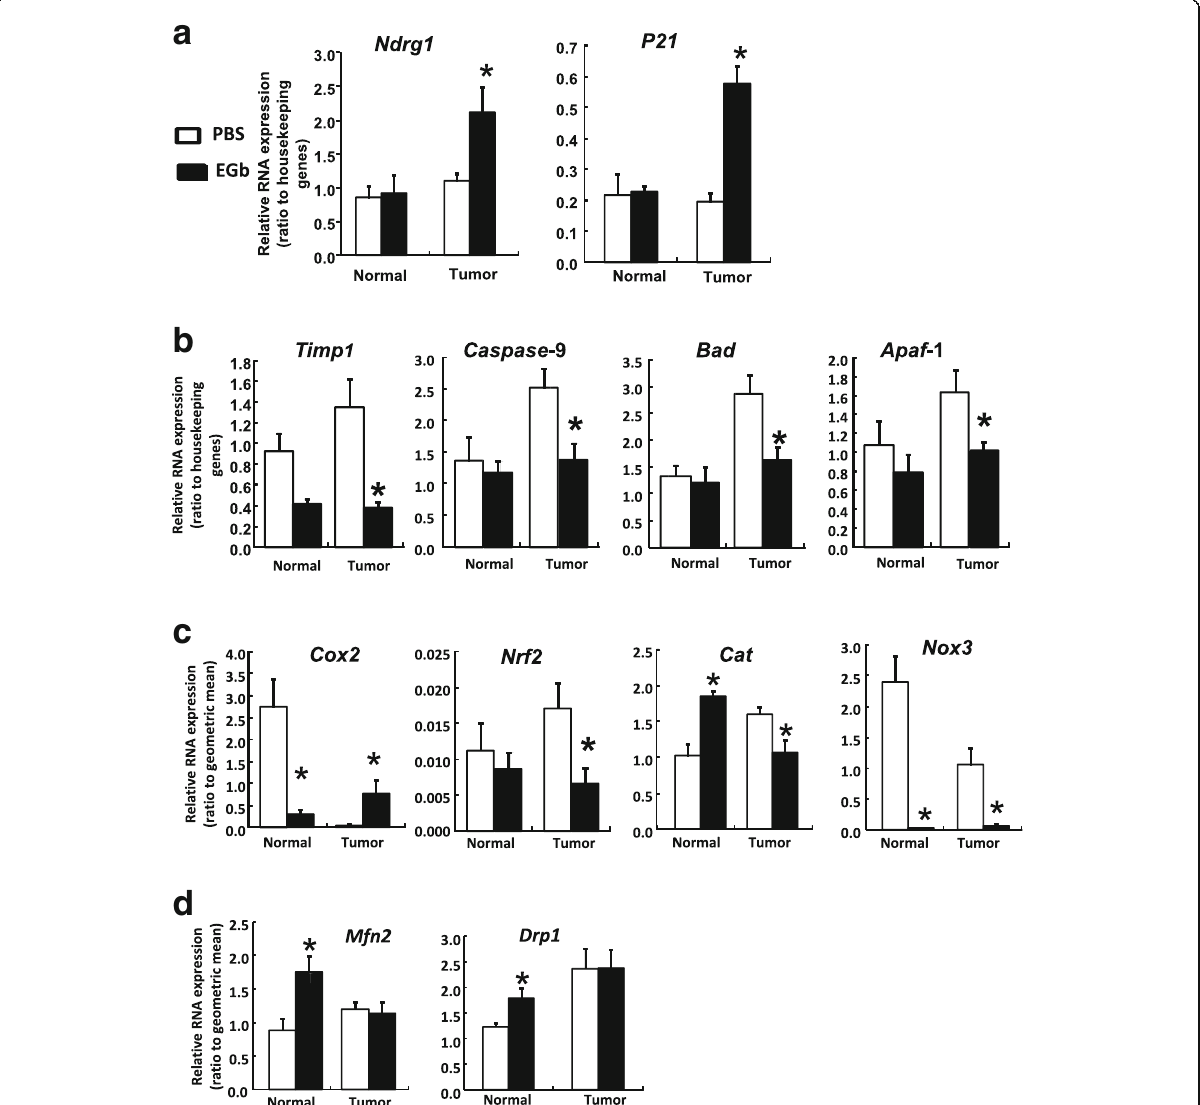
Fig. 3 Relative mRNA expression in mouse liver. mRNA expression was analyzed by two-step real-time RT-PCR using primers that are specific to mouse genes. All data were normalized to geometric mean of housekeeping genes including L7a, Tbp, 36B4, Actb, HPRT and GAPDH. BLI imaging at the beginning of EGb treatments was used to determine tumor development and to group animals into Tumor (animals with tumor development) and Normal (animals without detectable tumors). Open bars represent the PBS treated control group, and filled bars represent EGb treated group. a Expression of cell cycle and metastasis related genes in mouse livers. b Expression of apoptosis related genes. c Expression of oxidative stress related genes. d Expression of mitochondria function related genes. Data represent means ± SEM, n >5. Asterisks (*) indicate statistical significance ( p <0.05) when compared to the PBS